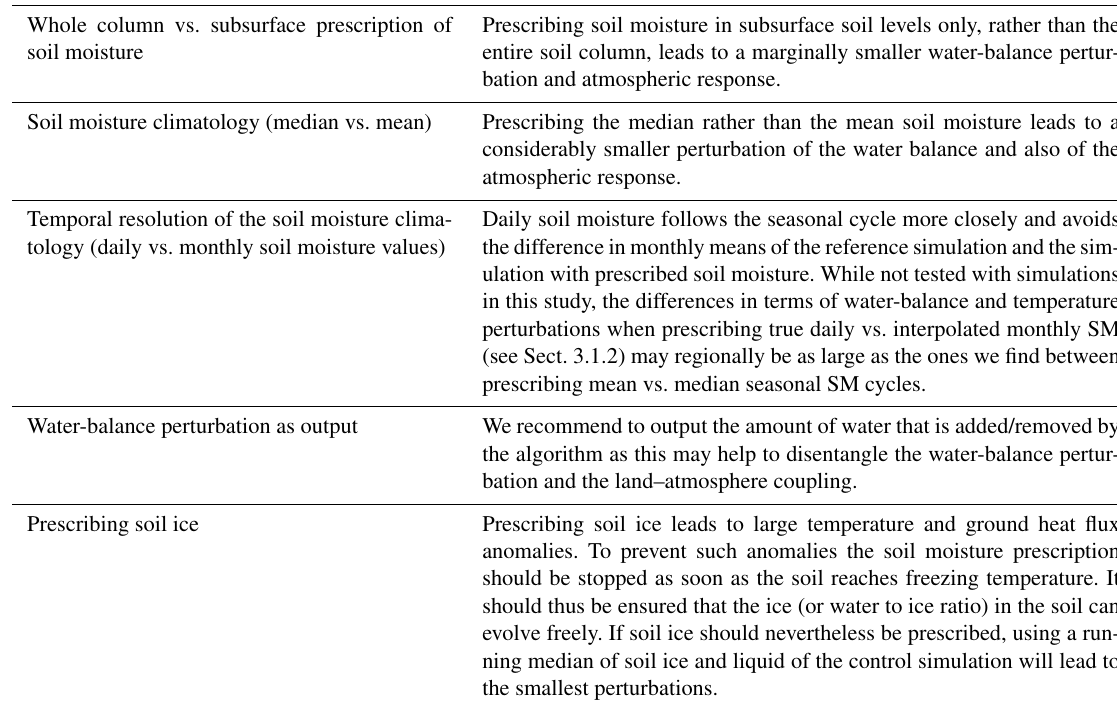
Table 2. Summary of the findings and recommendations for prescribing soil moisture in land surface models. Whole column vs. subsurface prescription